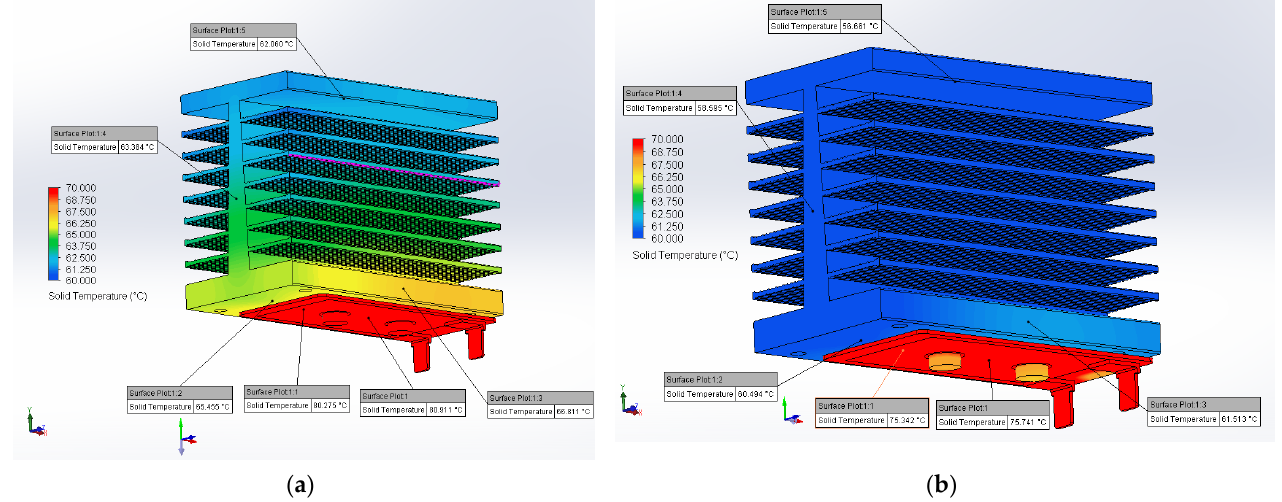
Figure 13. ( a ) Temperature plot of Setup 1 simulation; ( b ) Temperature plot of Setup 2 simulation.